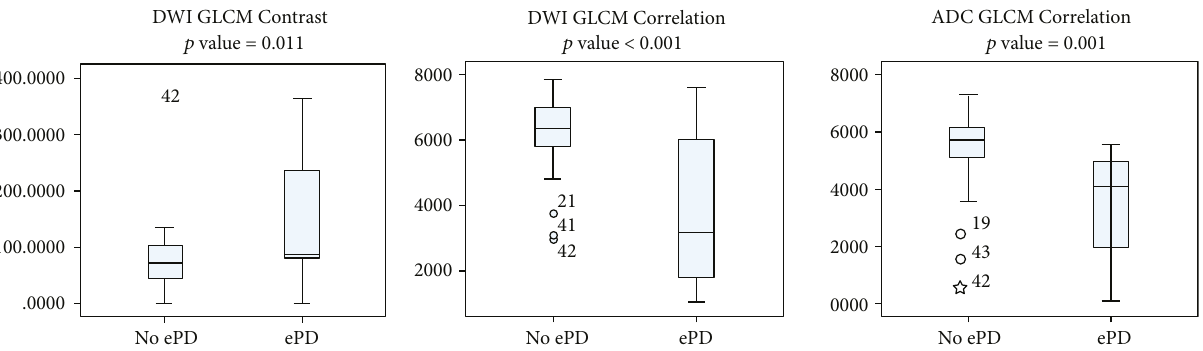
Figure 3: BoxPlot of the TA parameters in the two subgroups of patients who develop (ePD) or not develop (no ePD) early distant